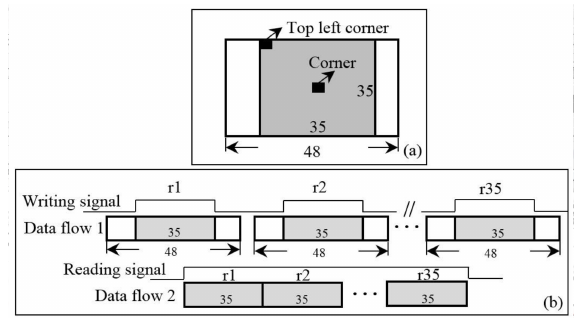
Figure 7. Image cutting module, ( a ) the location of top left corner determination; ( b ) a smaller sub-image clipping.